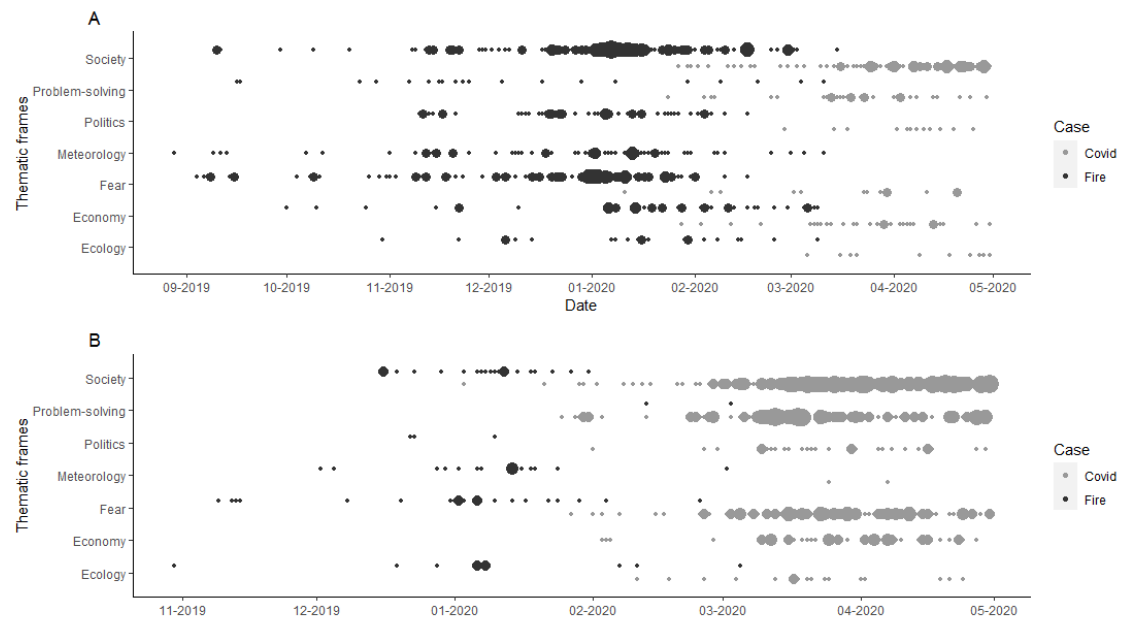
Figure 3. Distribution of thematic frames during the study period, The New Daily ( A ) and Index ( B ). The size of the spots is proportional to the number of articles.